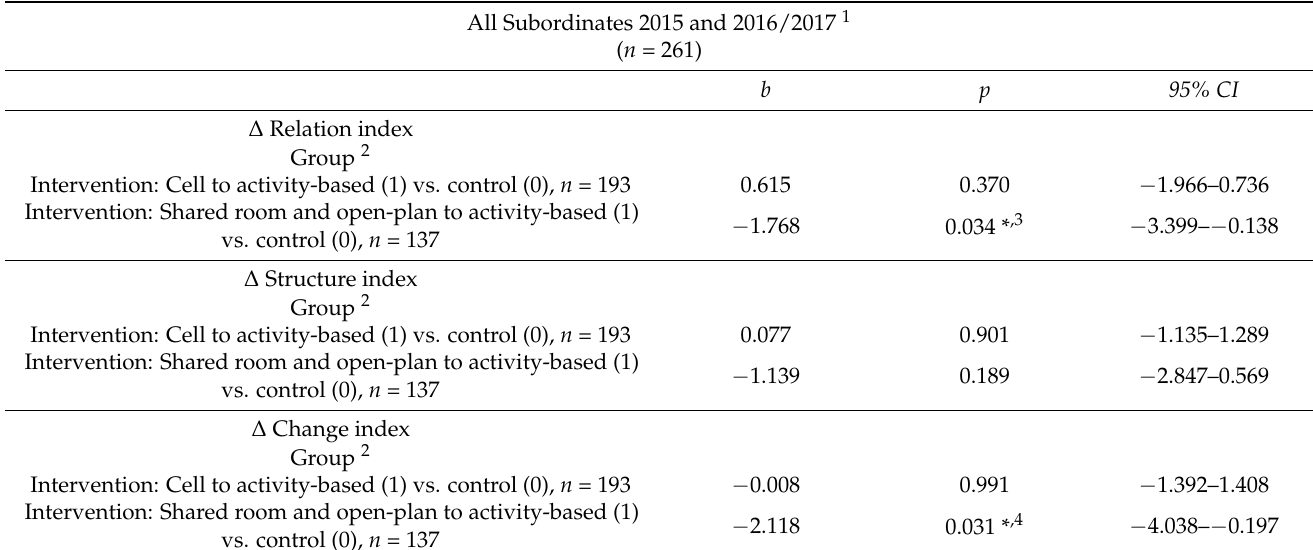
Table 6. OLS regressions with the transformed (added constant 31) ∆ Relation, ∆ Structure, and ∆ Change dimensions as dependent variables, n =